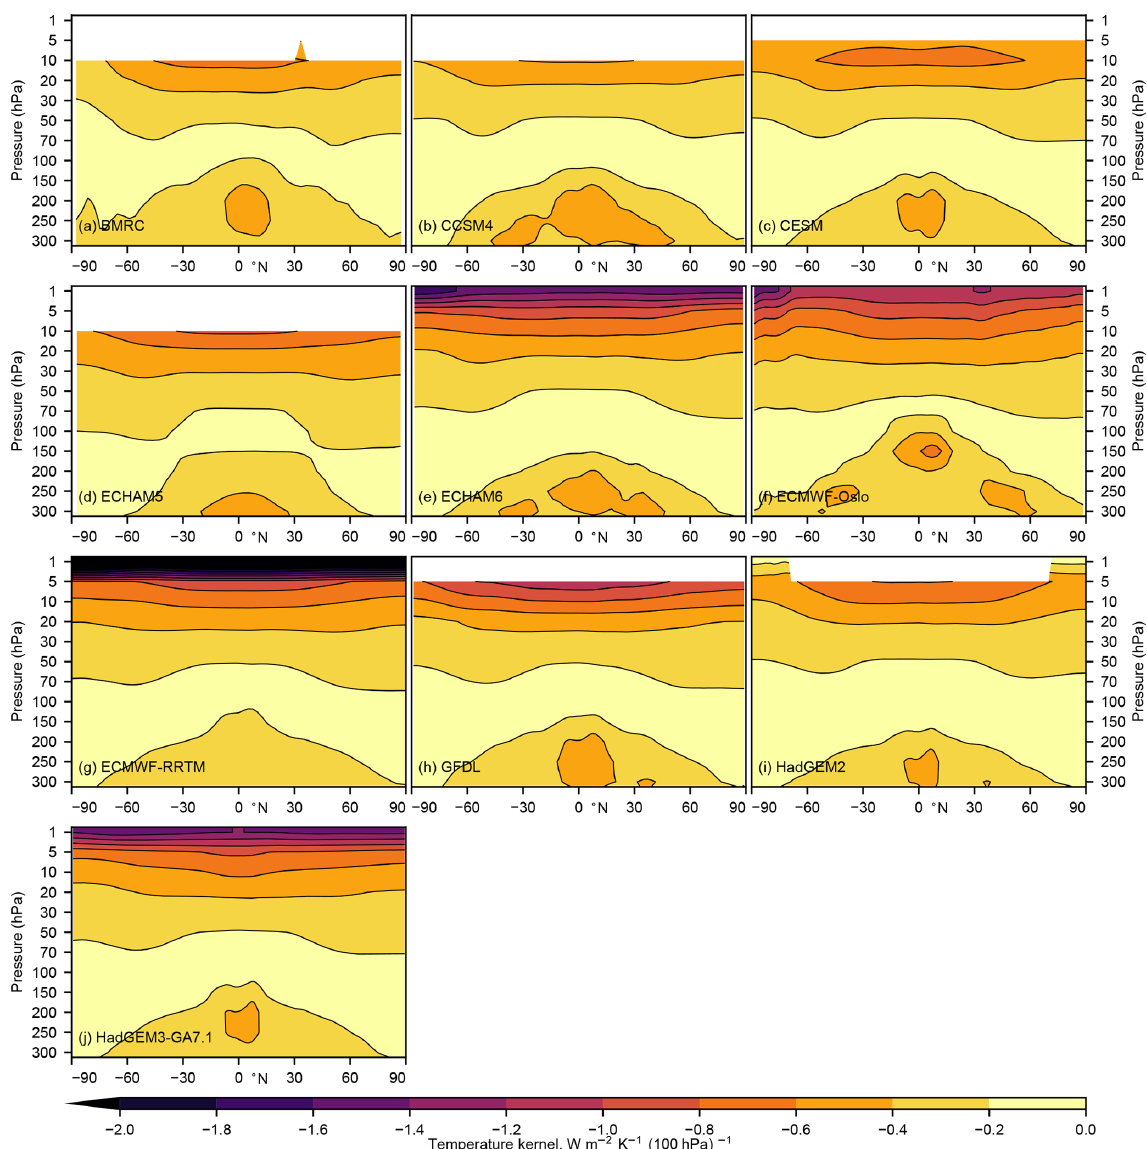
Figure 3. Air temperature radiative kernels available in the literature, truncated at 300hPa to show the stratospheric temperature contribution. Blank areas are above the top level of the